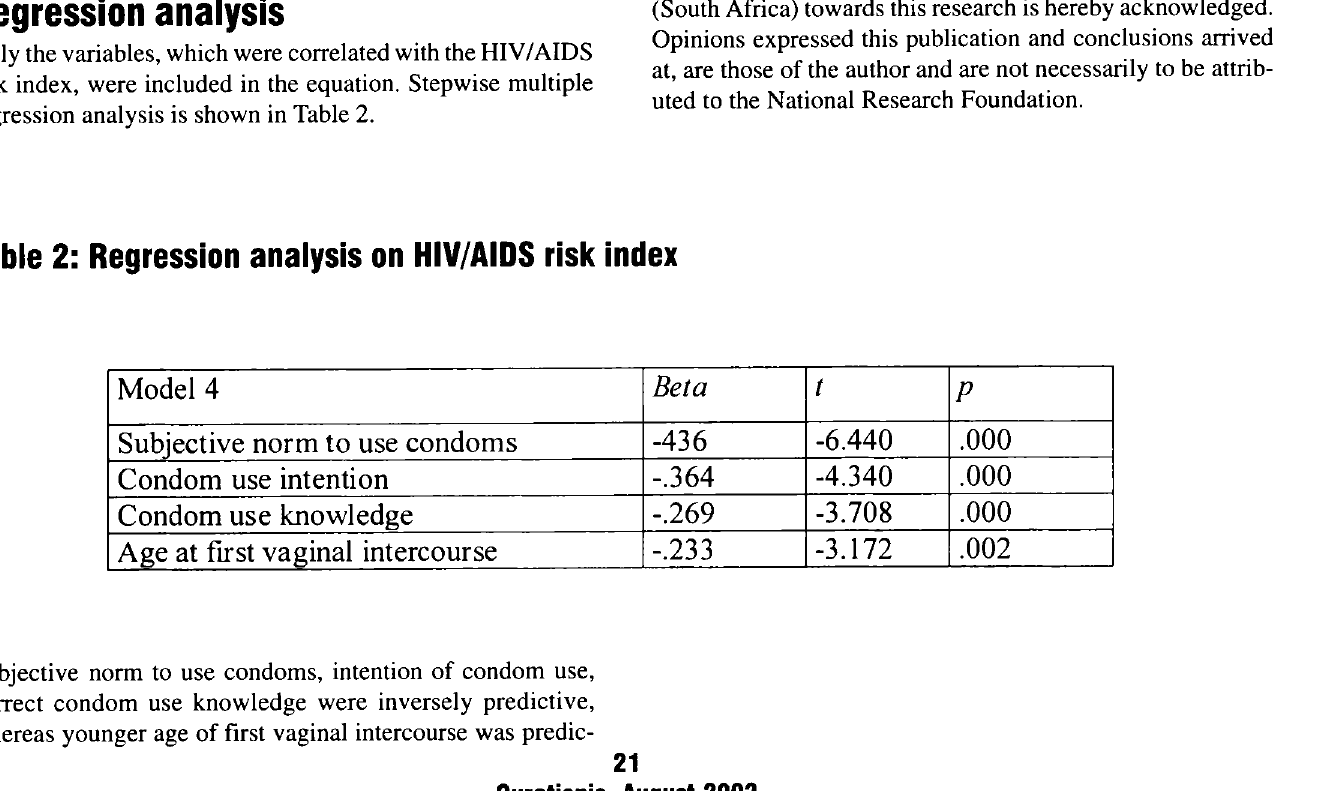
Table 2: Regression analysis on HIV/AIDS risk